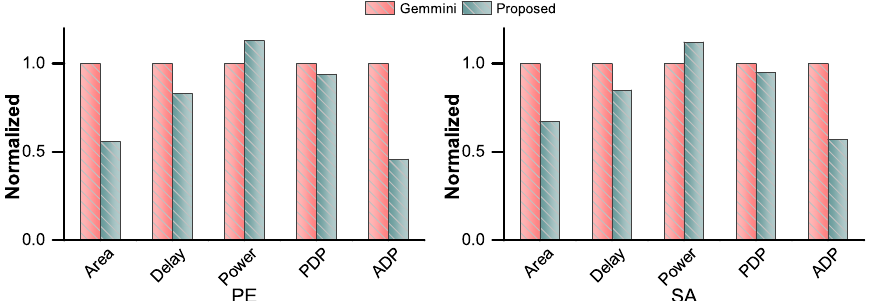
Figure 4. Performance comparison of 8 × 8 proposed CPA-Factored Gemmini PE, SA and baseline Gemmini PE,